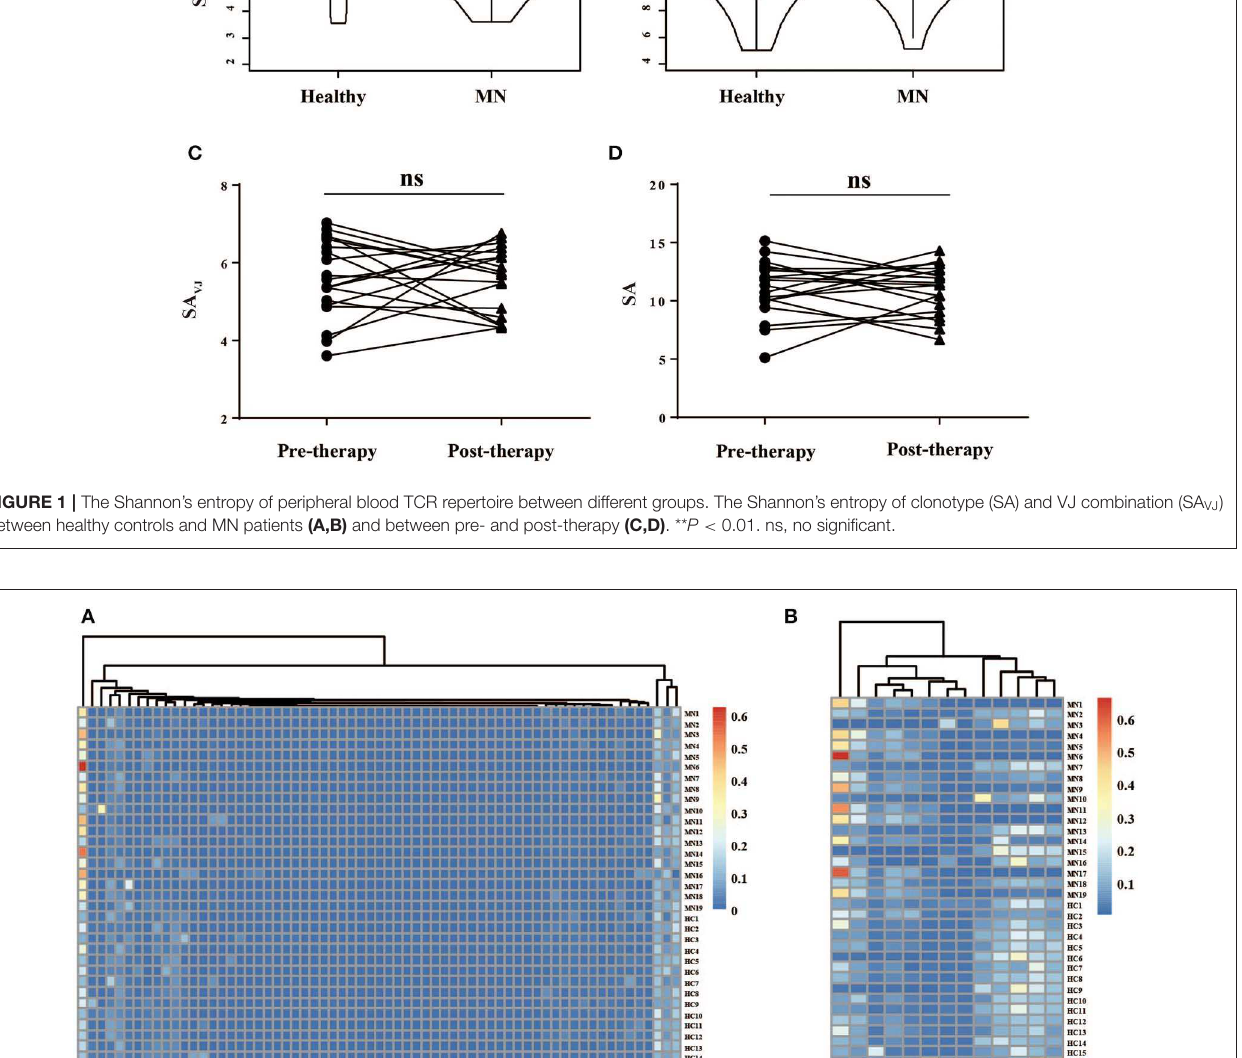
with negative antibodies and found that six V β genes (V β